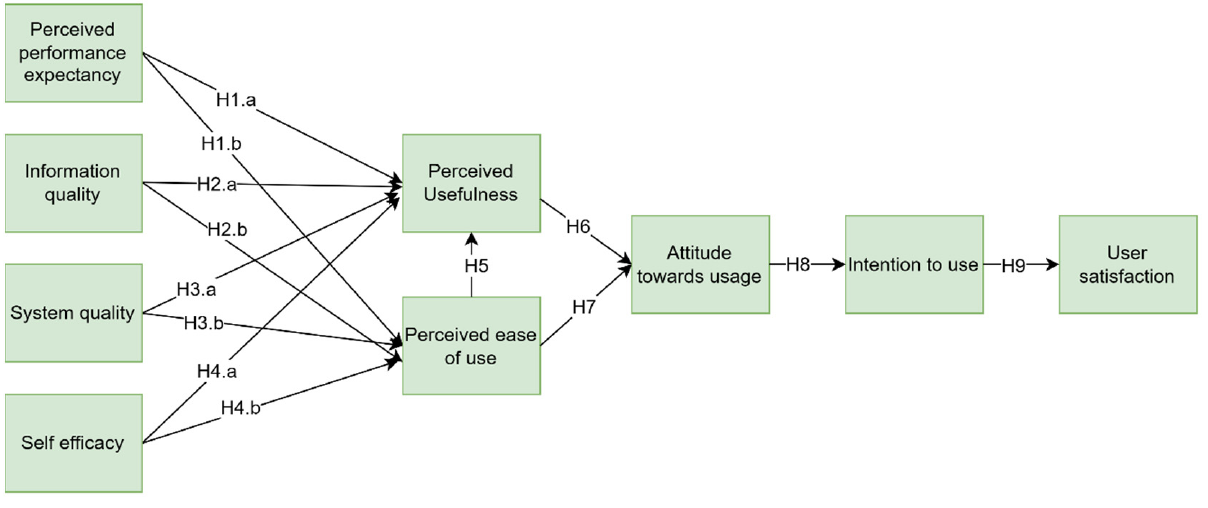
Figure 1. The acceptance model for interactive learning.